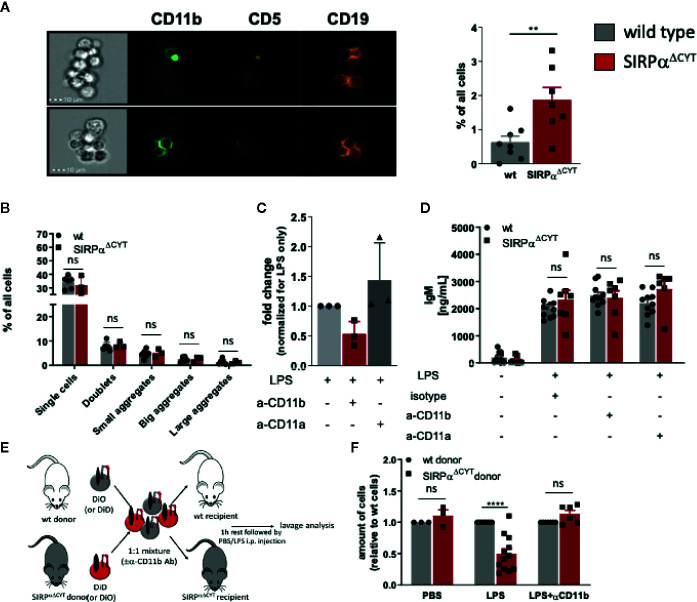
Loss of SIRPα signaling promotes LPS-induced CD11b/CD18 integrin-dependent B1 cell efflux from the peritoneal cavity. (A, B) Lack of SIRPα signaling promotes the formation of large aggregates in isolated SIRPαΔCYT peritoneal cavity (A) but not splenic (B) B1a cells (n = 6–8 mice/group). (C) Enhanced frequency of B1 cell large aggregates in SIRPαΔCYT peritoneal cavity B1a cells relative to wt cells is CD11b/CD18-integrin-dependent as it is reduced by blocking anti-CD11b, but not anti-CD11a antibodies. (D) Blockade of CD11b/CD18 or CD11a/CD18 integrins has no effect on IgM antibody production by peritoneal cavity B1 cells upon LPS stimulation. (E) Experimental design of egress of adoptively transferred mixed SIRPαΔCYT/wt B1 cells from the peritoneal cavity. (F) Evaluation of adoptively transferred mixed SIRPαΔCYT/wt B1 cells shows increased efflux of SIRPαΔCYT B1 cells relative to wt from the peritoneal cavity upon LPS stimulation and this enhanced egress is CD11b/CD18 dependent (n = 3–12 mice/group). Similar data were obtained for SIRPαΔCYT recipients (not shown). Data are presented as mean ± SEM. Statistical analysis was performed by unpaired Student t-test, corrected for multiple comparisons with Holm-Sedak method where applicable, **p < 0.01, ****p < 0.0001; ns, non-significant.